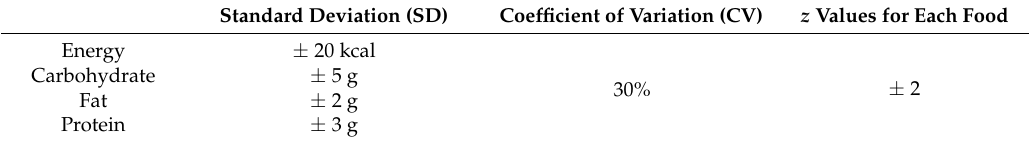
Table 1. Statistical criteria proposed for the definition of the food portions in each